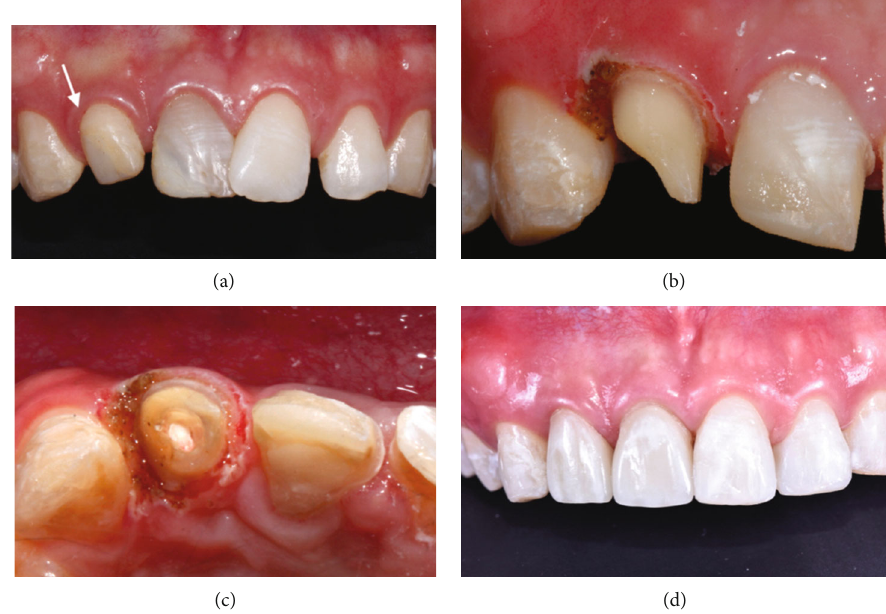
Figure 2: (a) Overlapping of maxillary central incisors and a peg-shaped lateral incisor built up with composite resin (arrow), (b, c) gingivoplasty on a lateral incisor, and (d) restored maxillary incisors and healed